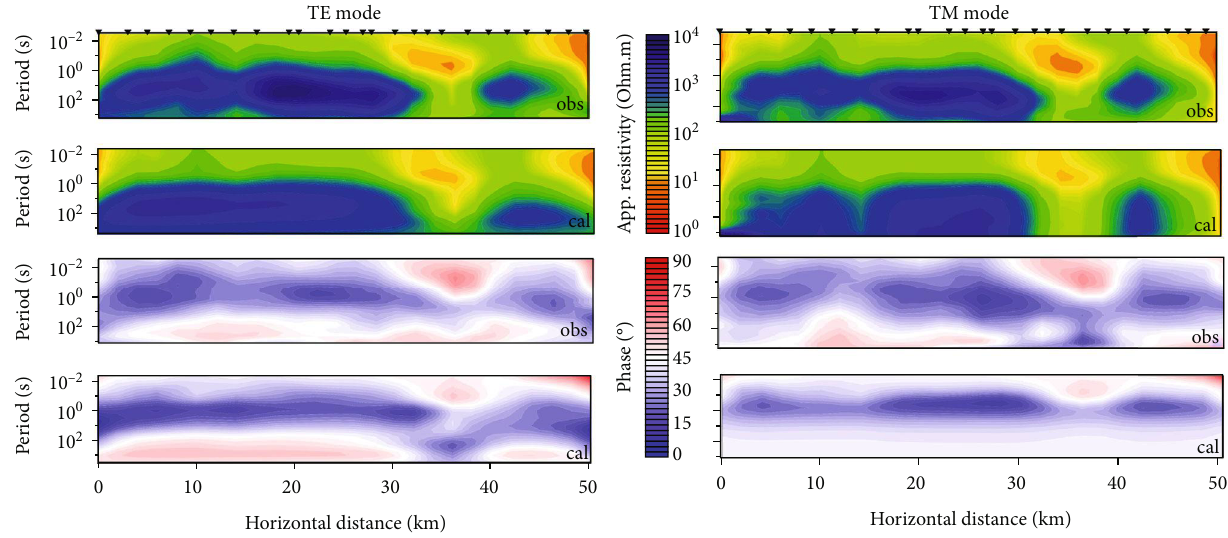
Figure 9: Apparent resistivity and phase pseudosection of MT model for line C-C ′ (northernmost line); observed (obs) and calculated (cal).